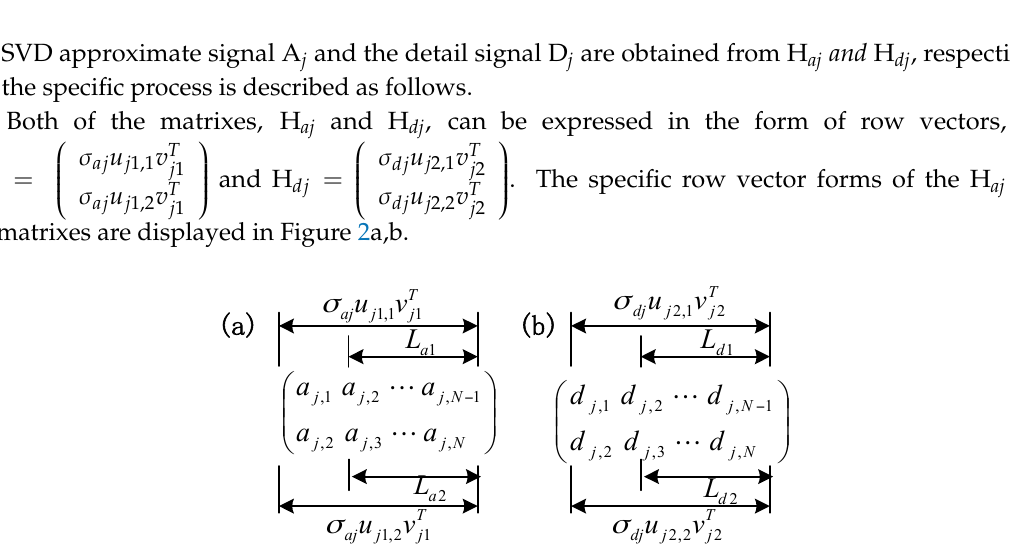
Figure 2. The specific row vector forms of the H aj and H dj matrixes. ( a ) The specific row vector forms of the H aj matrixes. ( b ) The specific row vector forms of the H dj matrixes.